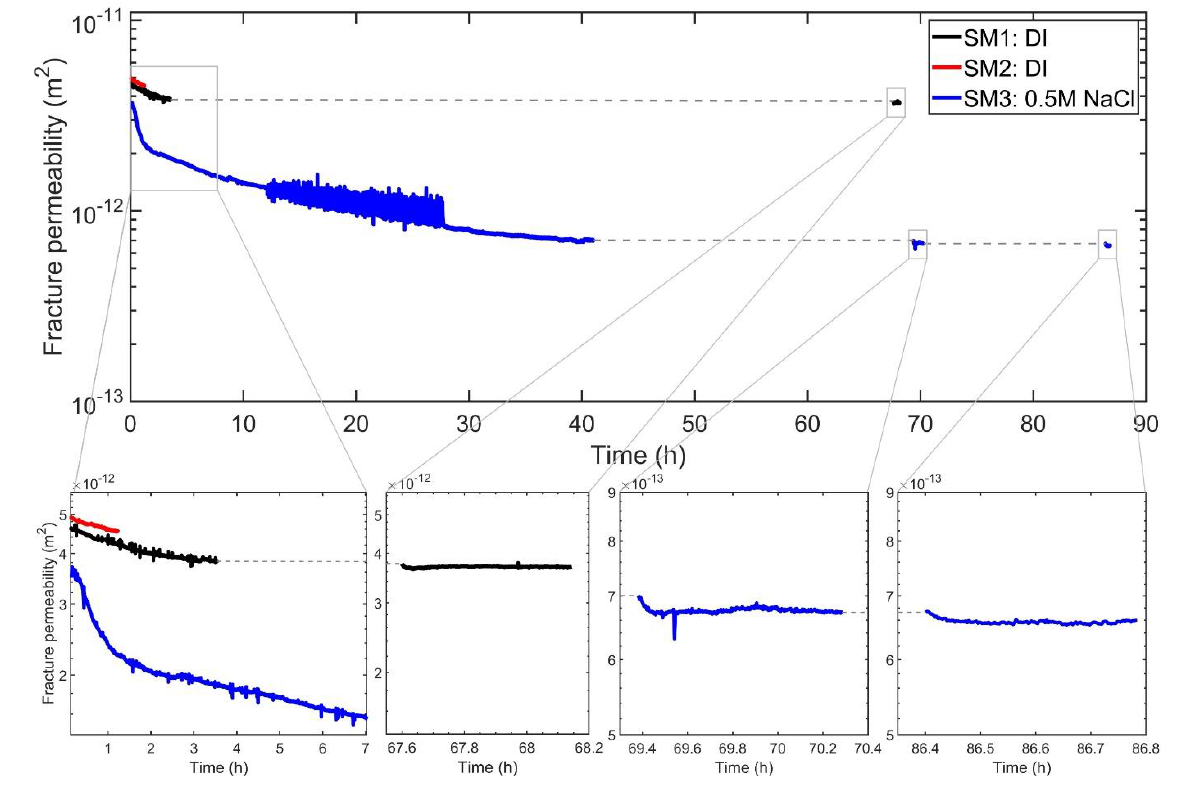
Figure 2. Fracture permeability determined by continuous flow tests after pressure build-up ( P c : 10 MPa and P p : 1 MPa) as a function of elapsed time at room temperature. The large fluctuation of SM3 permeability (blue line) between 13 and 27 h is because the upstream pump pressure reached a set limit, and the flow rate was automatically adjusted. Panels at the bottom show measurements after fluid flow was interrupted for certain time intervals.